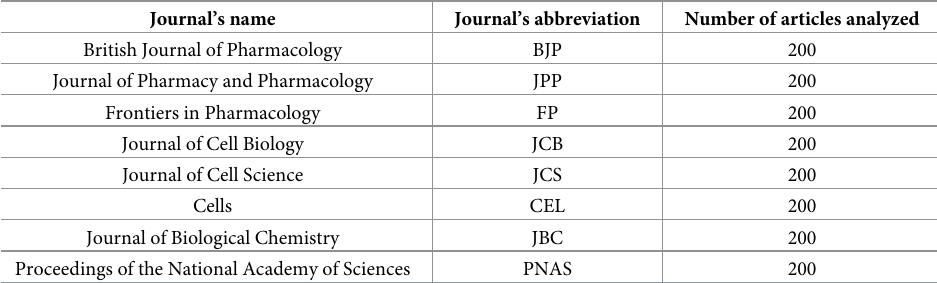
Table 1. Information on the biomedical sciences journals used in this